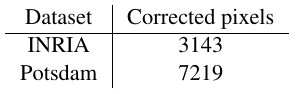
Figure 4. Comparison of the two different automatic evaluation processes on the INRIA (top) and Potsdam (bottom) datasets.